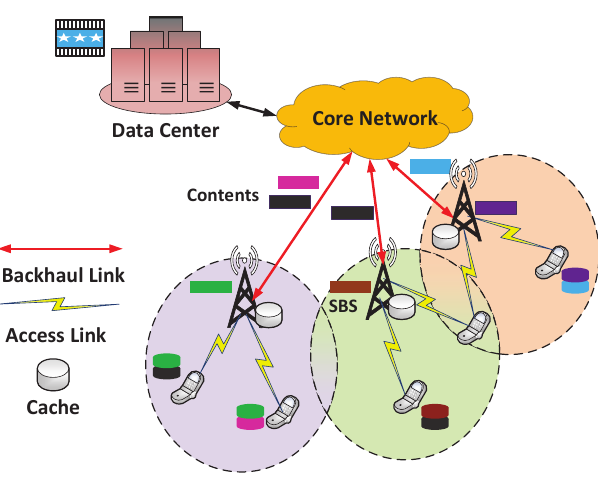
Figure 1. An illustration of data caching at